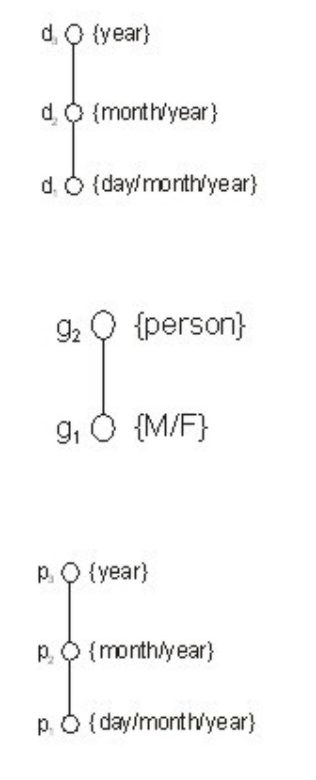
The three domain generalization hierarchies for the